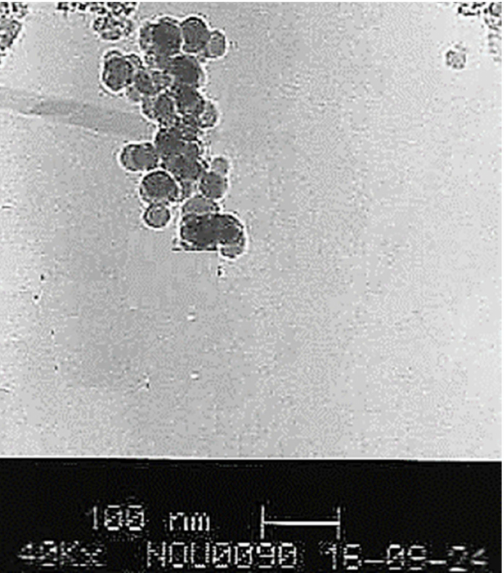
Figure 7. The transmission electron microscopy (TEM) image of the silicon oxide Nanoparticles depicting the uniformity of the particle distribution. These particles appeared to have the dimensions of <100